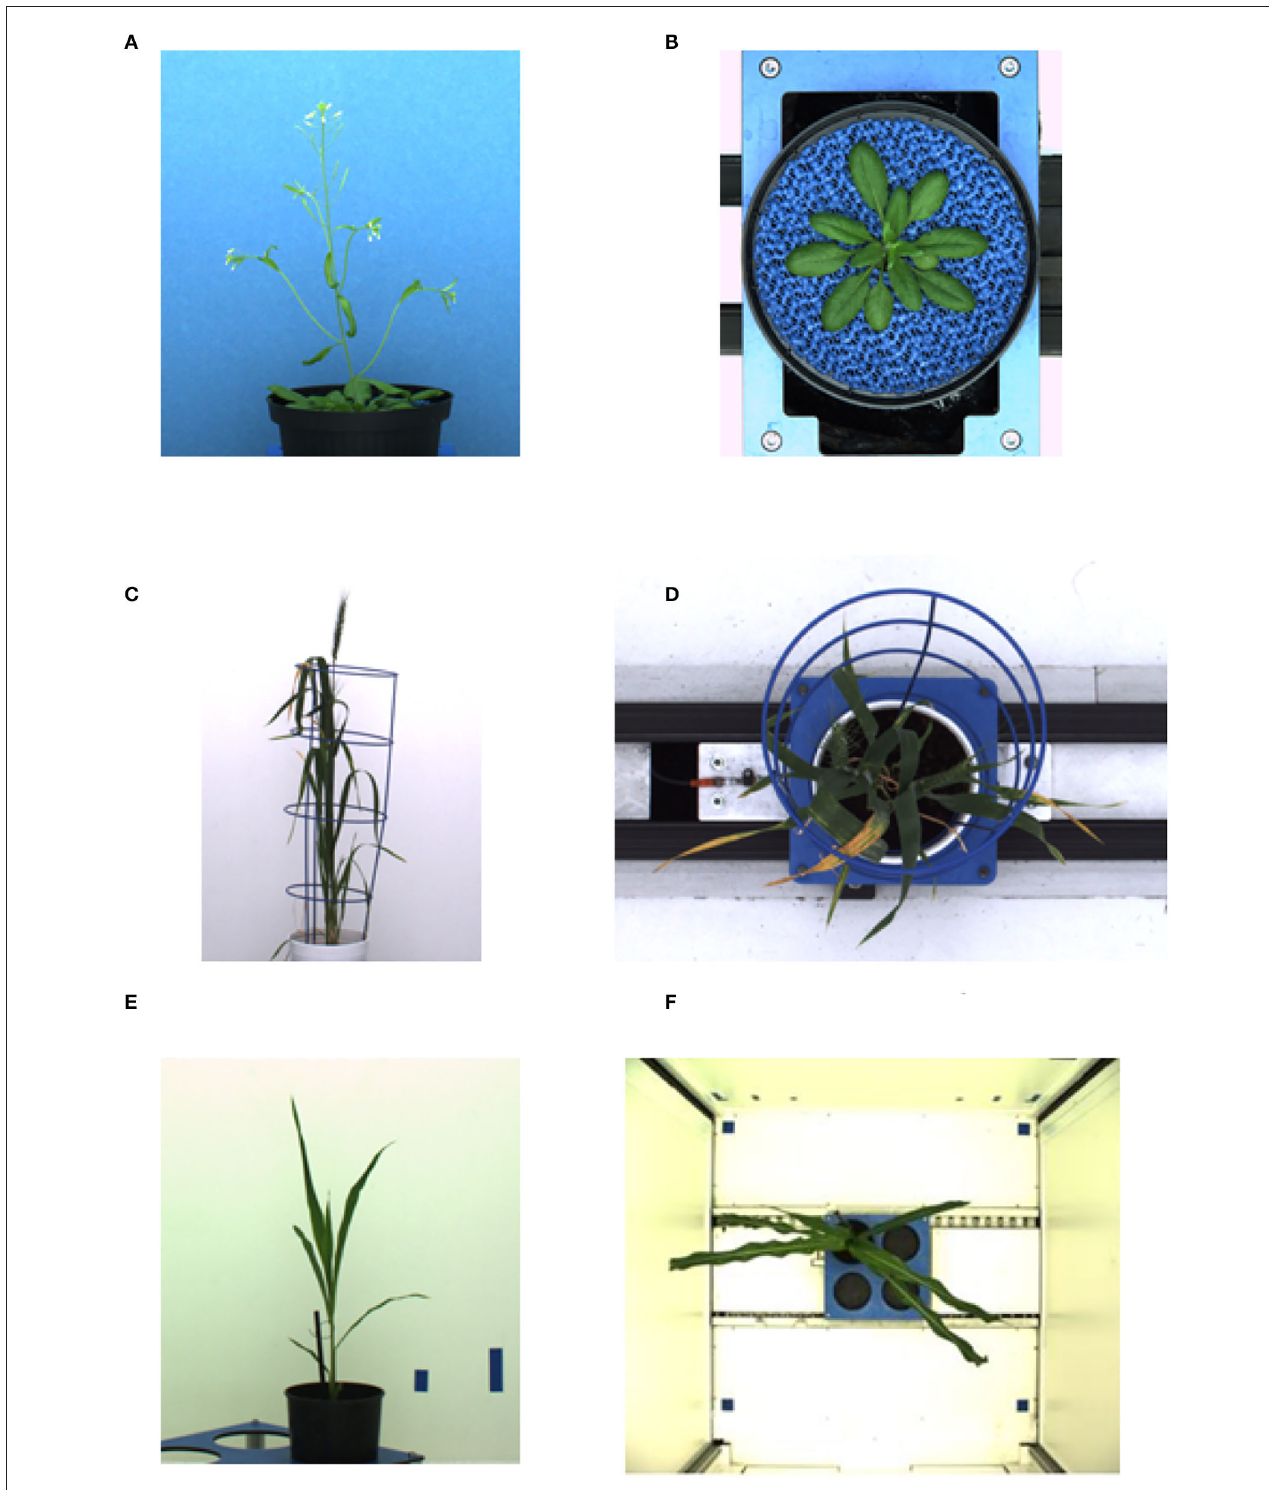
FIGURE 1 | Examples of side- and top-view images of arabidopsis (A,B) , barley (C,D) , and maize (E,F) plants acquired with three different plant phenotyping platforms.